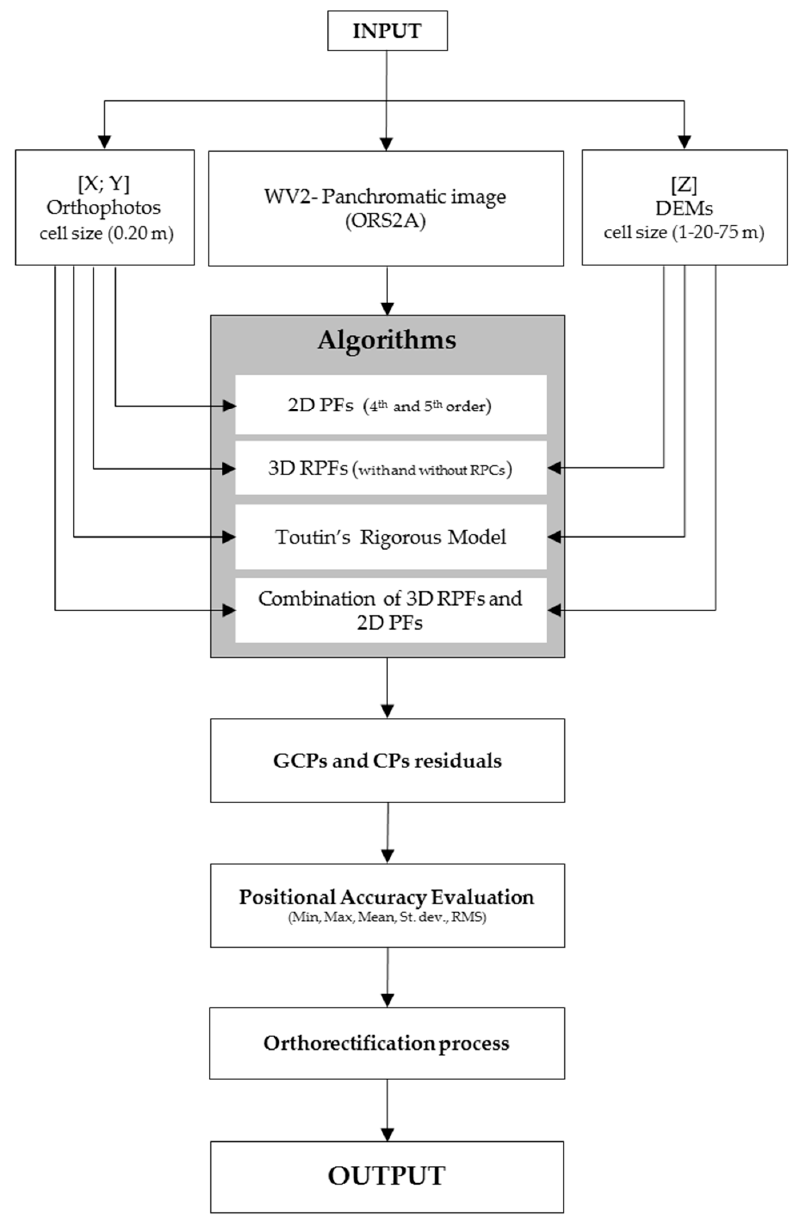
Figure 3. Flowchart of the orthorectification process.